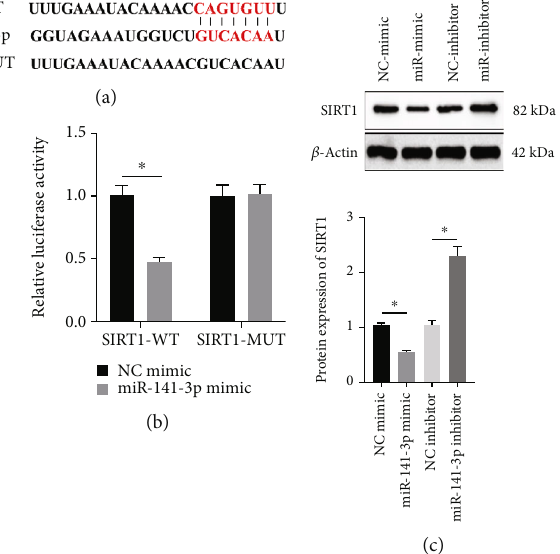
Figure 3: miR-141-3p regulates SIRT1 expression via targeting its 3 ′ UTR. (a) The predicted binding sites. (b) Inhibiting e ff ect of miR-141- 3p mimic on luciferase activity of SIRT1-WT. (c) The miR-141-3p regulated SIRT1 protein level. ∗ P < 0 : 05